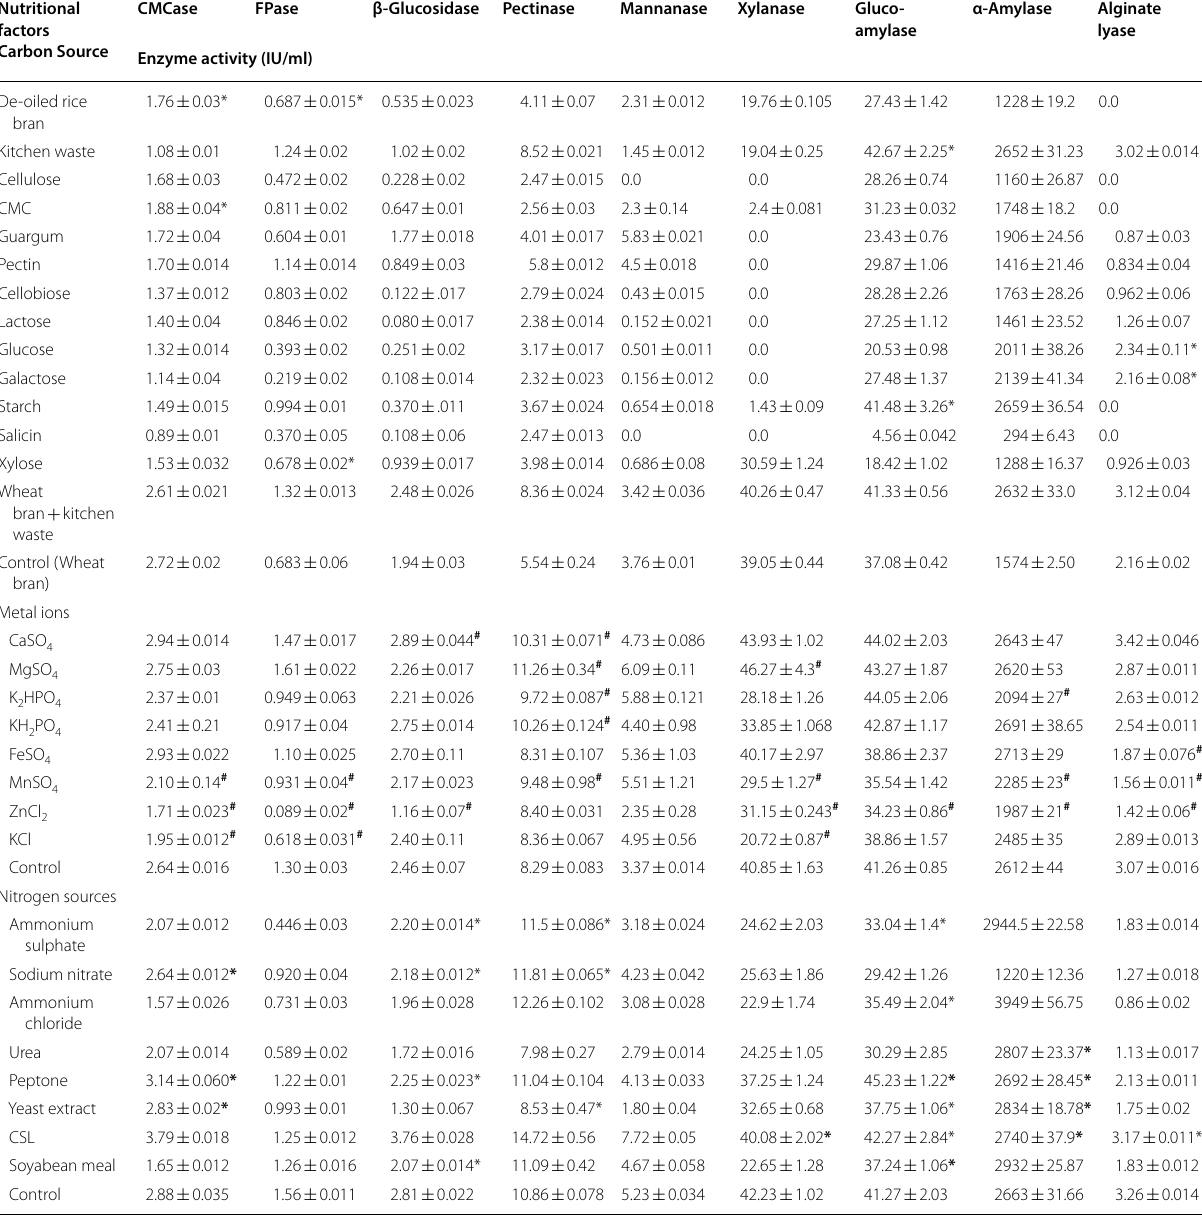
In case of carbon and nitrogen sources, all the values differ from the control significantly (p < 0.001) by Dunnett’s Multiple Comparison Test except those marked with*. In case of metal salts all the values marked with# differ from the control significantly (p < 0.001) by Dunnett’s Multiple Comparison